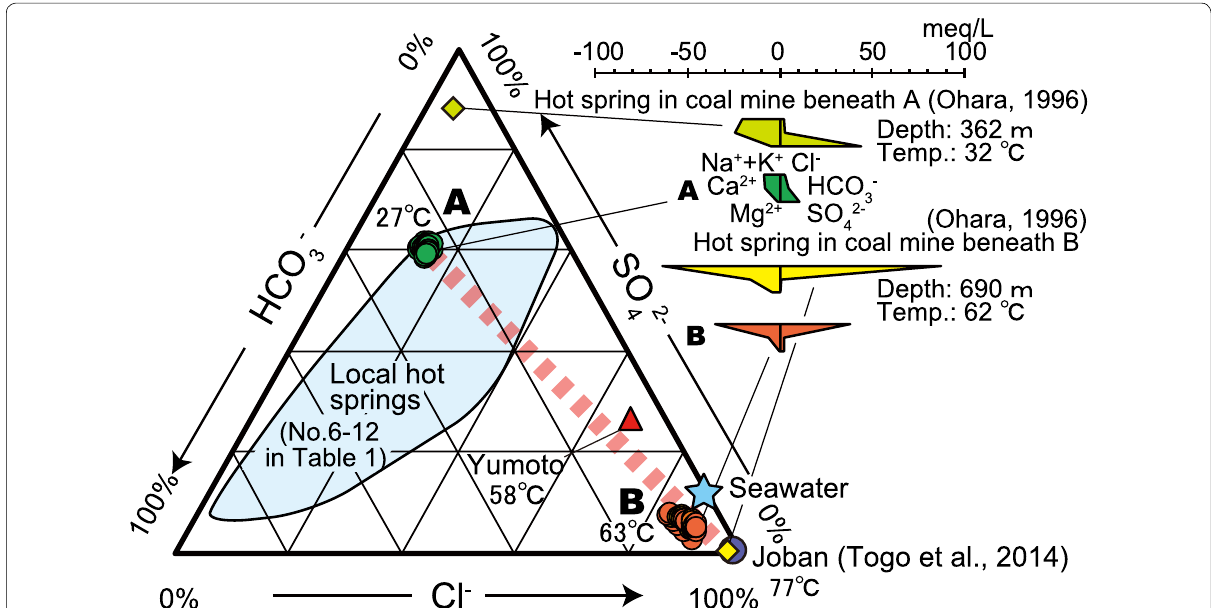
Fig. 3 Triangular diagram showing major anionic component ratios of hot spring water in study area. Light blue and purple areas indicate hot spring plot ranges from No. 6 to 12 in Table 1 and Joban plot range by Togo et al. (2014), respectively. Stiff diagrams indicate major chemical concentrations of A and B just after Iwaki earthquake, and hot springs in coal mine beneath A and B (Ohara